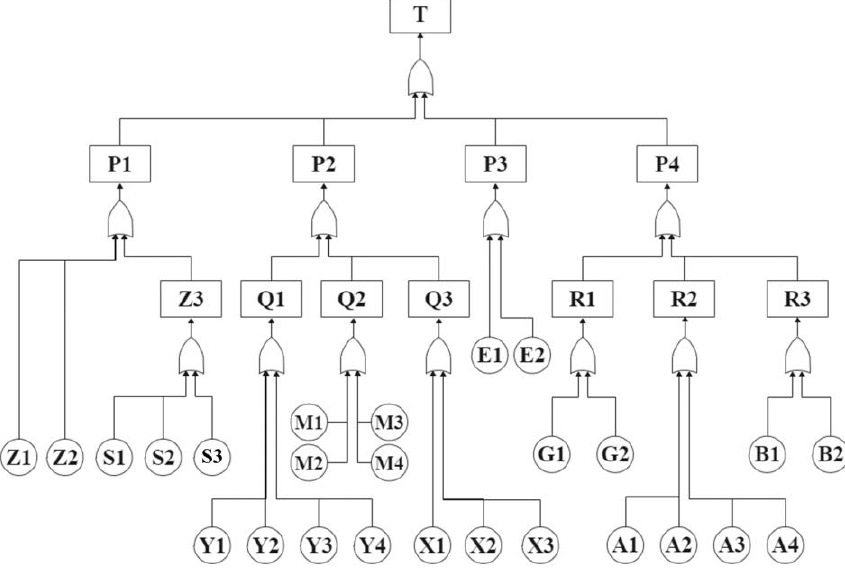
J. Mar. Sci. Eng. 2022 , 10 , x FOR PEER REVIEW Figure 6. Fault tree model for disconnect operations. Figure 6. Fault tree model for disconnect operations.